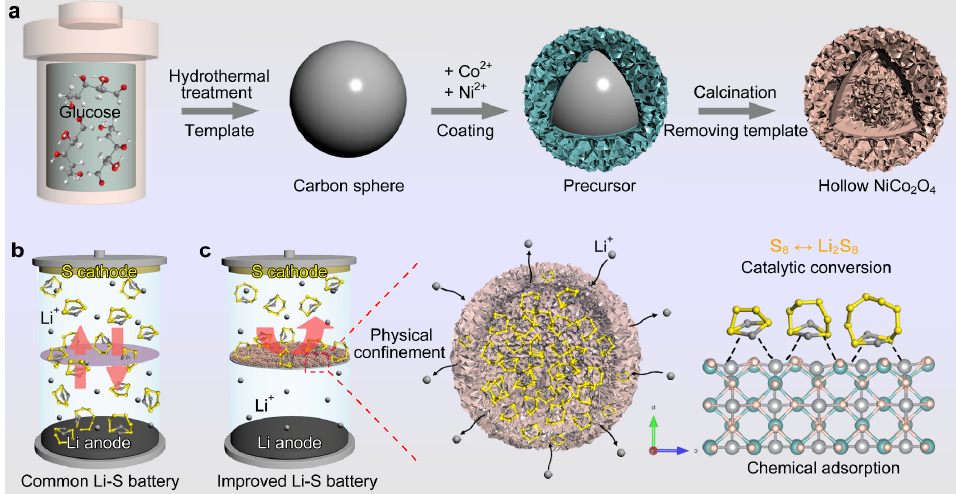
Figure 1. Schematic diagrams of ( a ) the synthesis process of NiCo 2 O 4 hollow nanospheres, ( b ) a Li–S battery with a common PP separator, and ( c ) an improved Li–S system using a NiCo 2 O 4 @PP separator for minimizing the issues of